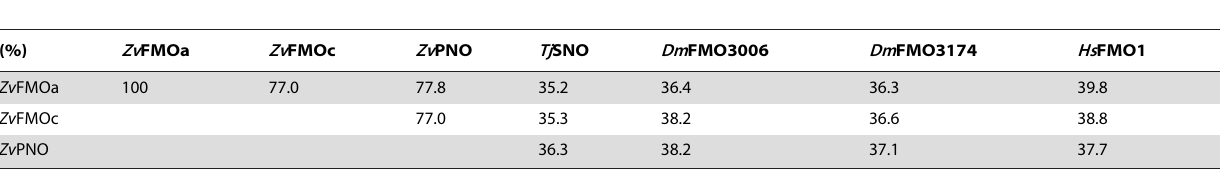
Table 1. Degree of identity between amino acid sequences encoding FMOs of Z. variegatus , other insects, and the FMO1 of human.